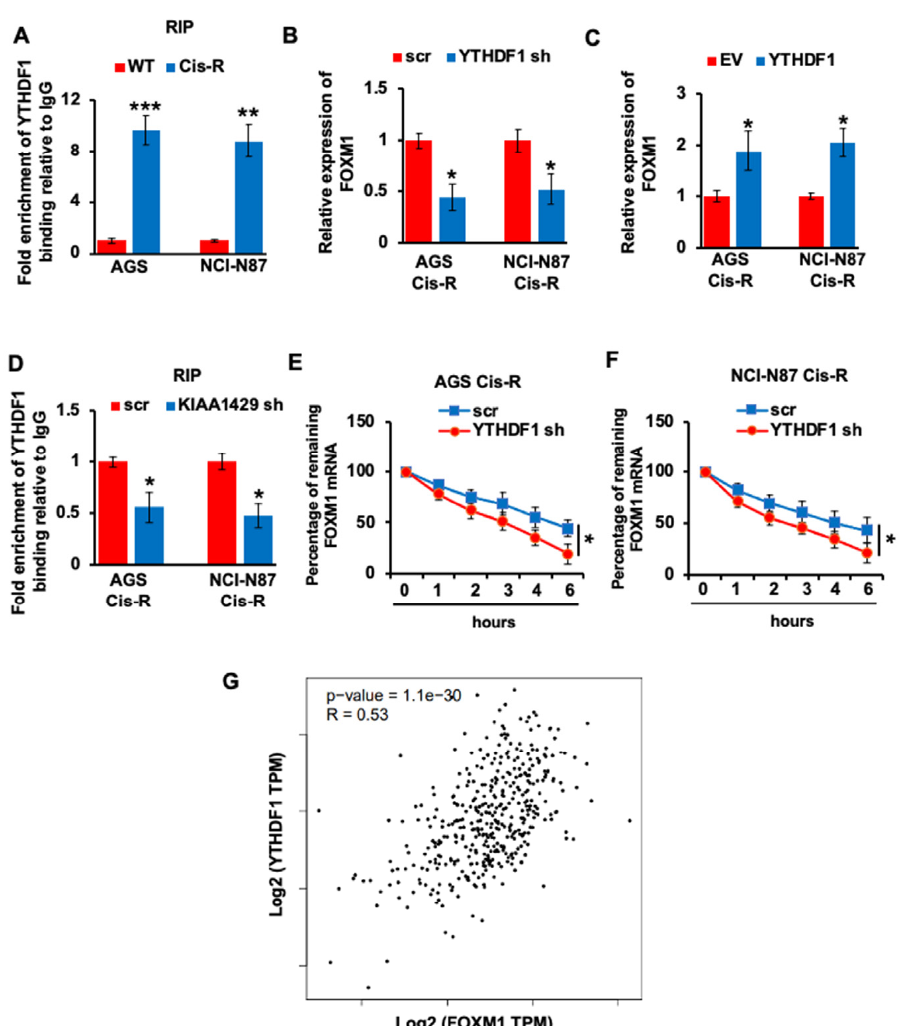
Figure 5. Effect of YTHDF1 on regulating FOXM1 expression. ( A ) RNA immunoprecipitation (RIP) indicated the direct binding within YTHDF1 and FOXM1 mRNA in AGS Cis-R or NCI-N87 Cis-R and their parental wild type cells. ( B , C ) The mRNA level of FOXM1 in YTHDF1 shRNA infected ( B ) or YTHDF1 overexpressed ( C ) AGS Cis-R or NCI-N87 Cis-R cells was assessed by QRT-PCR. ( D ) RNA immunoprecipitation (RIP) indicated the direct binding within YTHDF1 and FOXM1 mRNA in KIAA1429 shRNA infected AGS Cis-R or NCI-N87 Cis-R cells. ( E , F ) RNA decay rate assay demonstrated the FOXM1 mRNA half-lives upon the YTHDF1 knockdown in AGS Cis-R ( E ) or NCI- N87 Cis-R ( F ) cells. Data were detected at indicated timepoint with actinomycin D (Act D, 5 µ g/mL) treatment. ( G ) Correlation analysis by Spearman’s rank correlation coefficient (GEPIA) showed the correlation between YTHDF1 and FOXM1 in the gastric cancer tissue specimens. * p < 0.05, ** p < 0.01, *** p < 0.001.